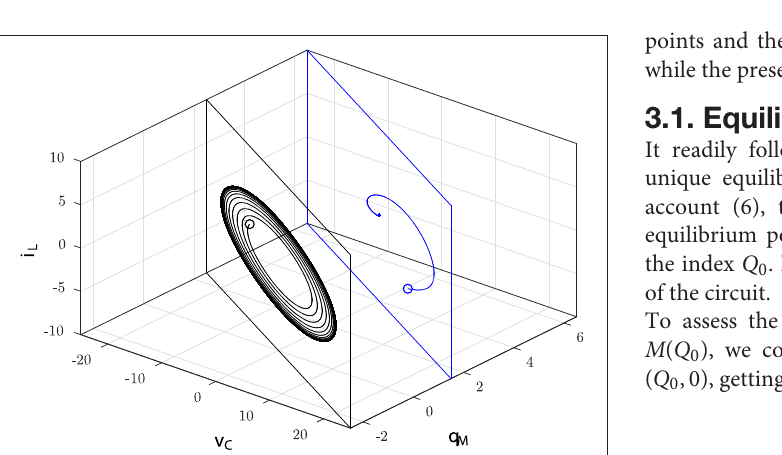
FIGURE 3 | Invariant manifolds of the input-less circuit: the state space trajectory generated by the solution of Equation (3) with initial conditions v C ( t 0 ), q M ( t 0 ), i L ( t 0 ) (marked with t 0 belongs to the manifold M ( Q 0 ) with ) at time t ◦ = Q 0 q M ( t 0 ) Cv C ( t 0 ) for all t t 0 = + ≥